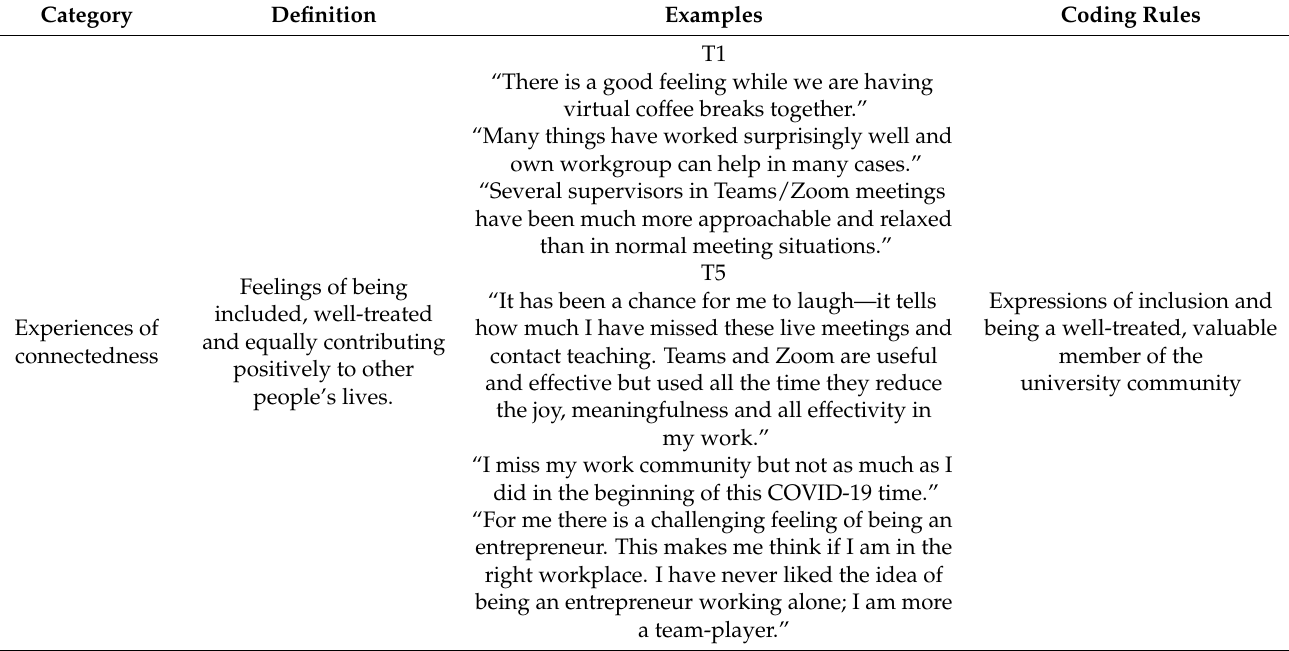
Table 3. Experiences of connectedness affecting the experience of relatedness at remote